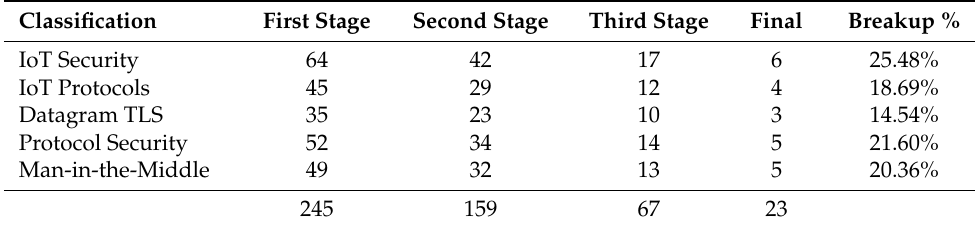
Table 1. Research-paper categories.